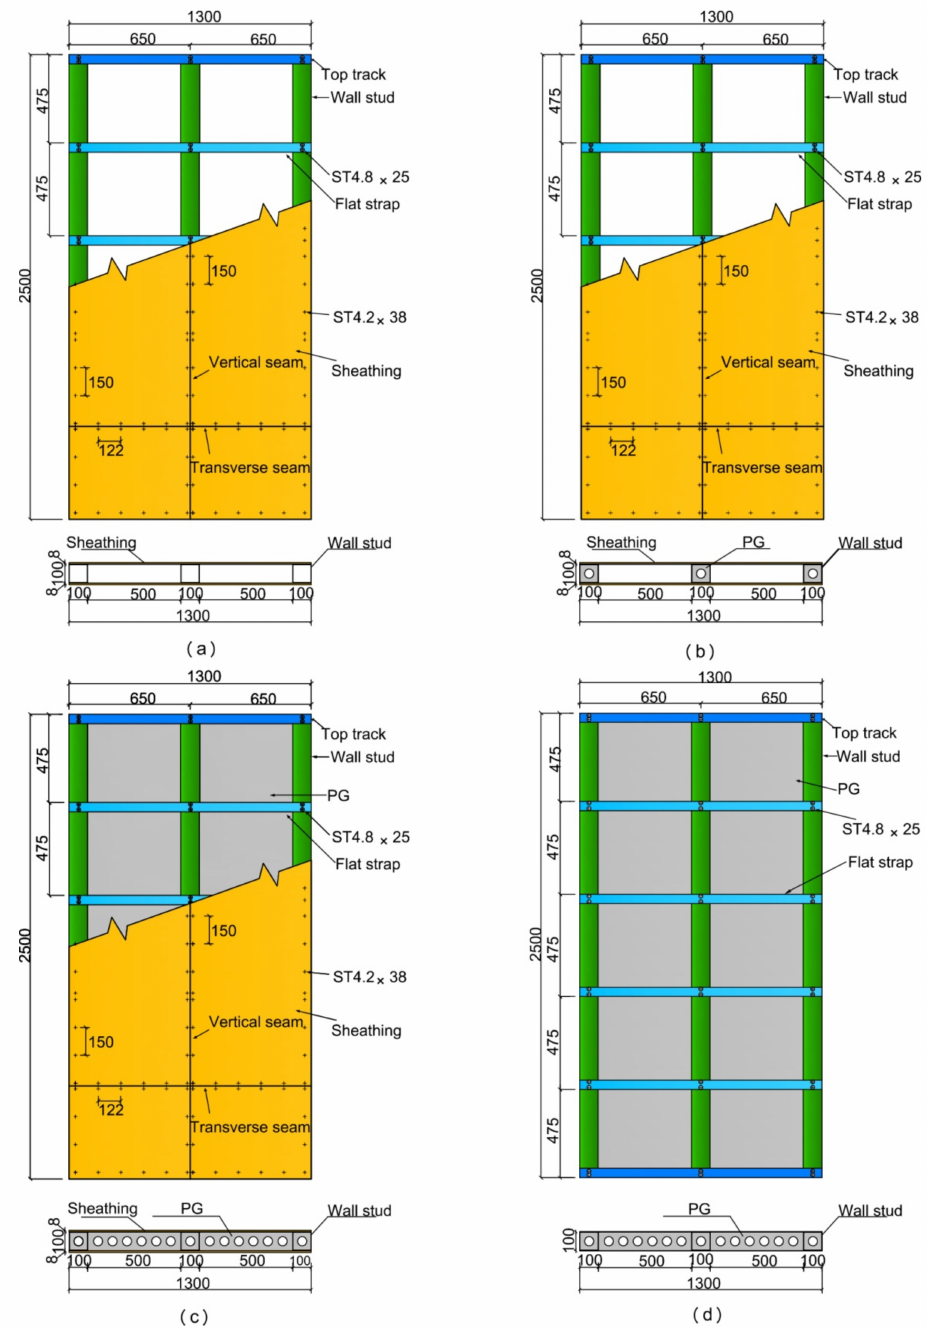
Figure 1. Dimensions and details of specimens. ( a ) Specimen W1; ( b ) specimen W2; ( c ) specimen W3; ( d ) specimen